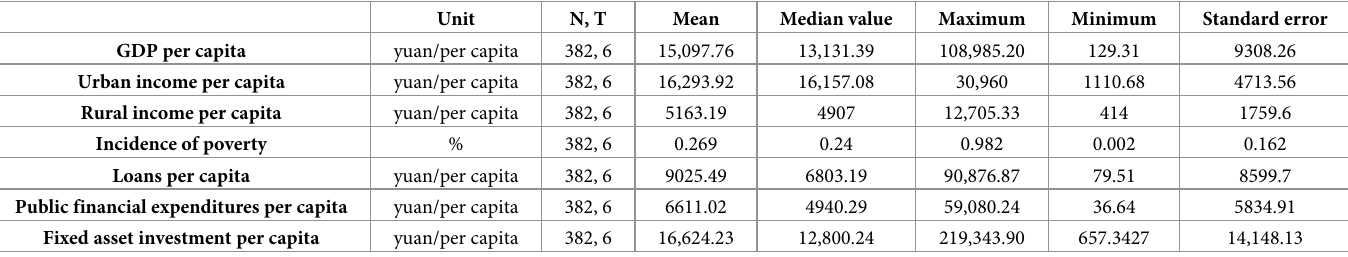
Table 2. Statistical characteristics of each variable